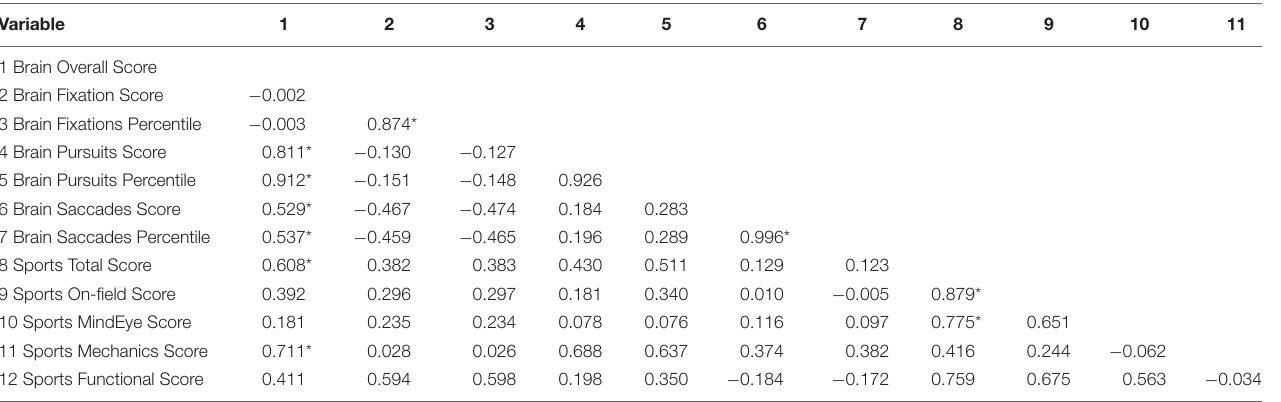
TABLE 5 | Correlation statistic between variables for batsmen.